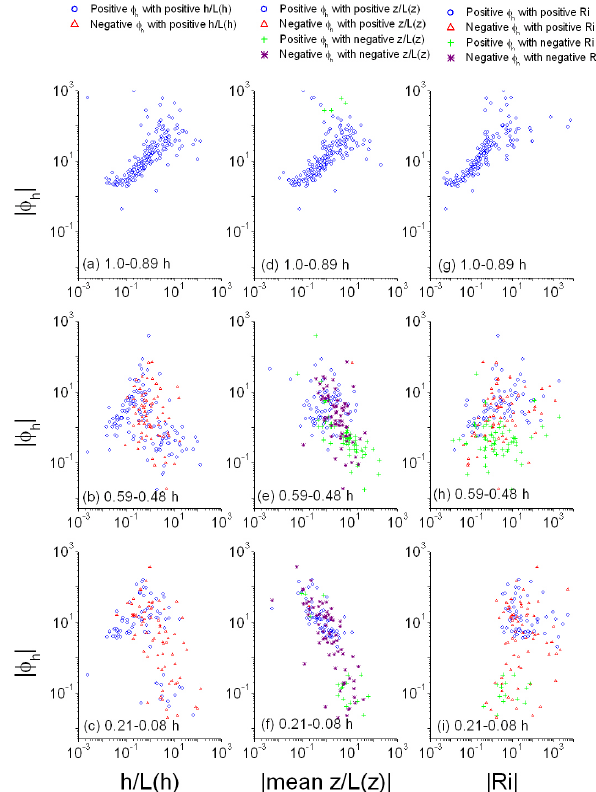
Fig. 5. Comparison of the relationship of the local similarity func- tion of temperature φ h with different atmospheric stability param- eters, h/L(h) at tree top, mean local z/L(z) , and local Richardson number Ri , in the top (1.0–0.89h), middle (0.59–0.48h) and low (0.21–0.08h)